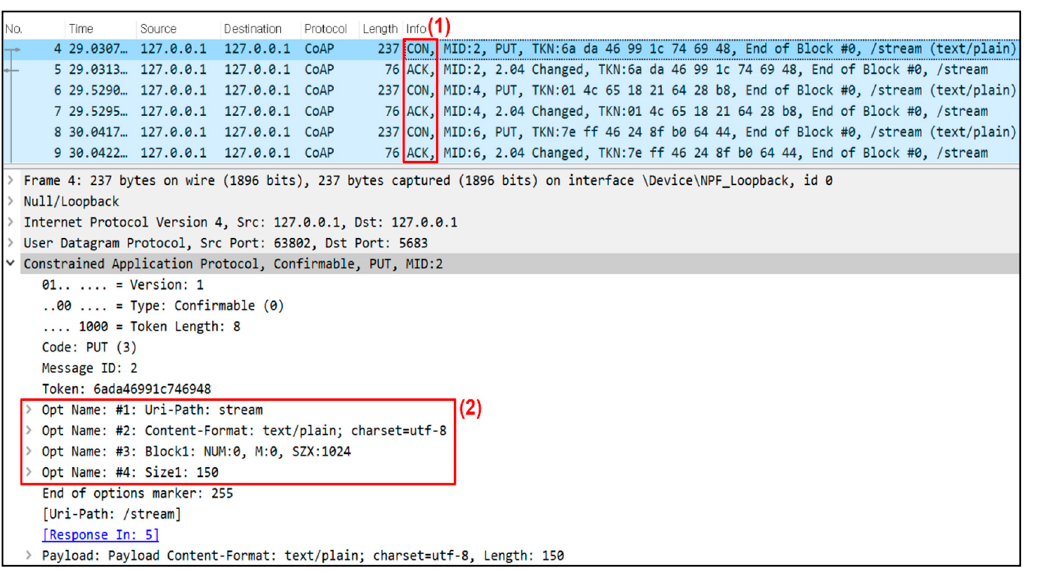
Figure 2. Packet analysis for CoAP over UDP.